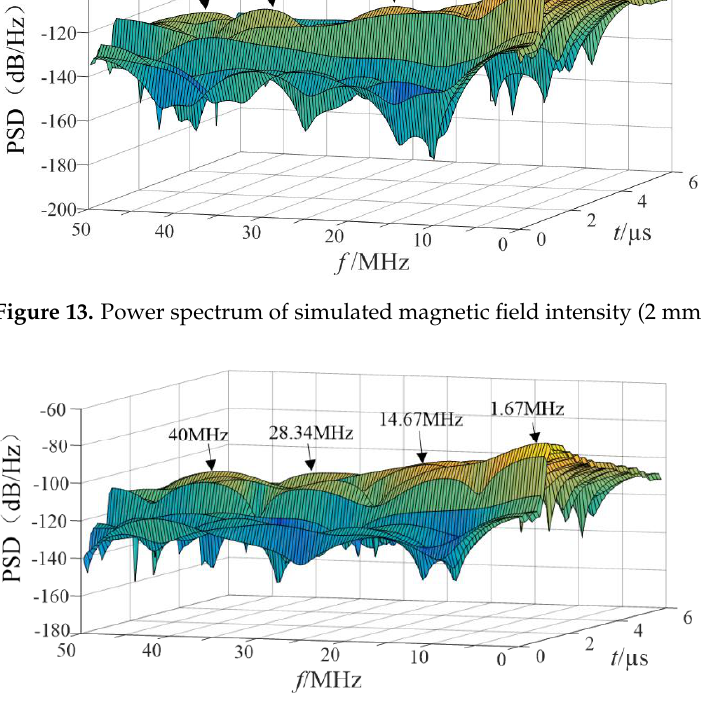
Figure 14. Power spectrum of simulated magnetic field intensity (3 mm).